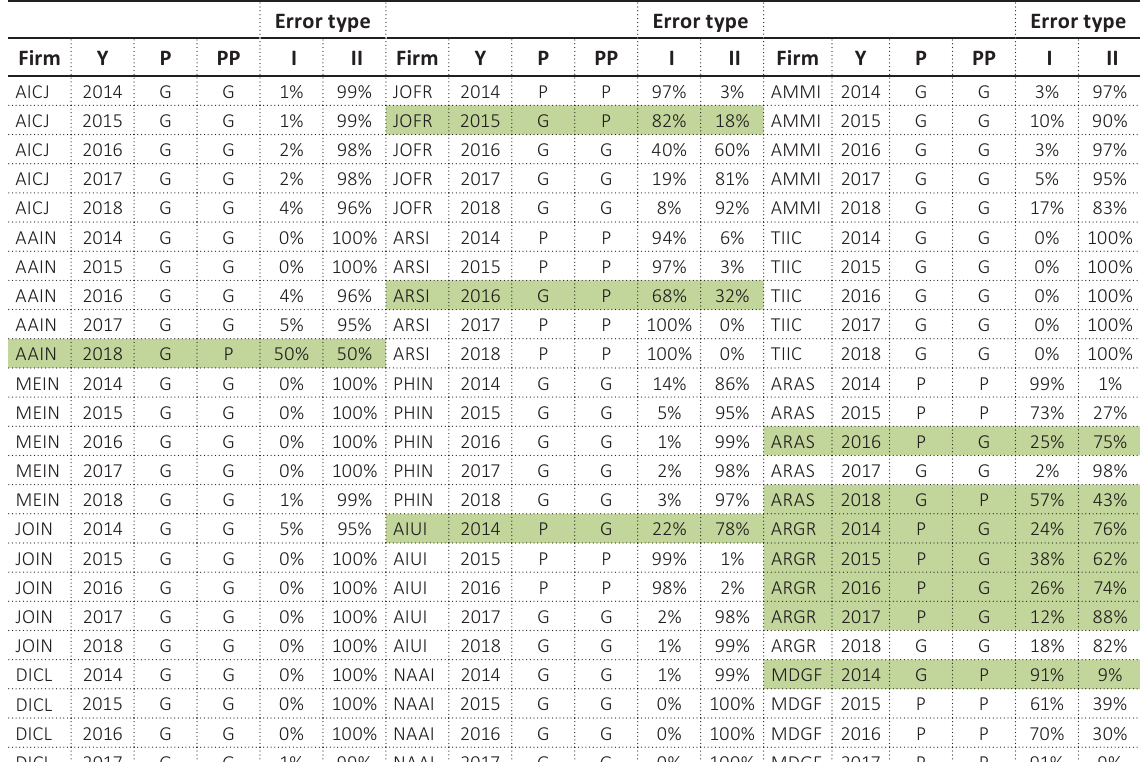
Table 7. Performance vs. predicted